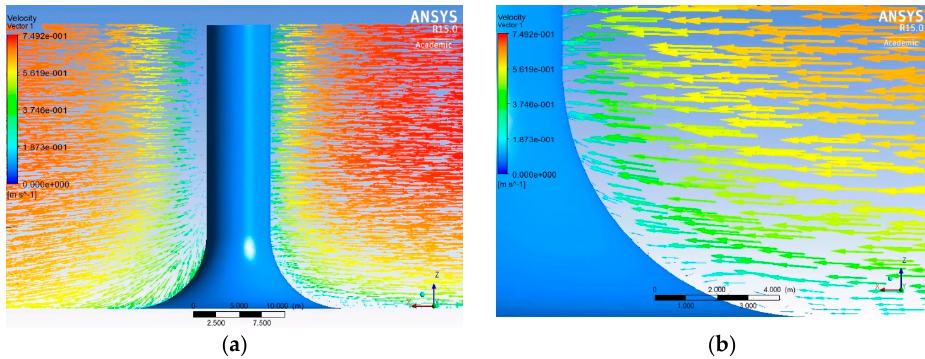
Figure 9. Velocity vectors on the symmetric plane xz after using the SEMCD: ( a ) plane view; ( b ) details of the flow in front of the monopile Energies 2018 , 11 , x